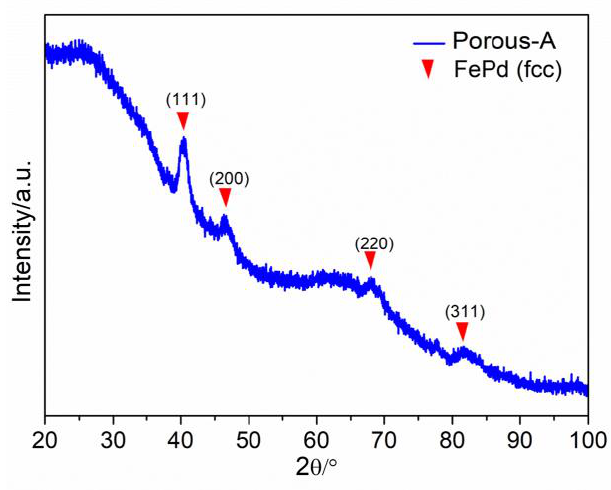
Figure 5. EDS maps of Porous-B NW ( a ) showing the presence and distribution of Pd ( b ) and Fe ( c ) throughout the length of the NW.